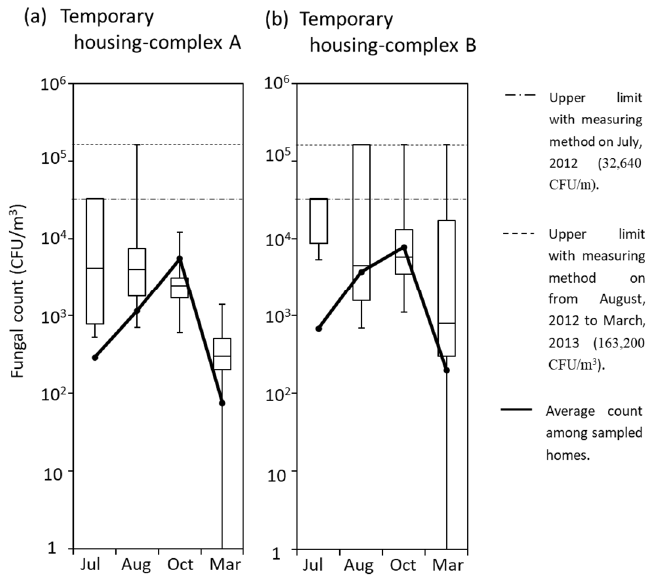
Figure 5. Comparison among fungal counts at four seasons in two temporary housing-complexes; ( a ) temporary housing-complex A and ( b ) temporary housing-complex A. We collected samples four times a year for covering four seasons (rainy season in July, summer in August, autumn in October, and winter in March). The 16 homes in the temporary housing-complex A and the 22 homes in the complex B were sampled. Boxplots were formed in each data-set of fungal counts on DG-18 agar